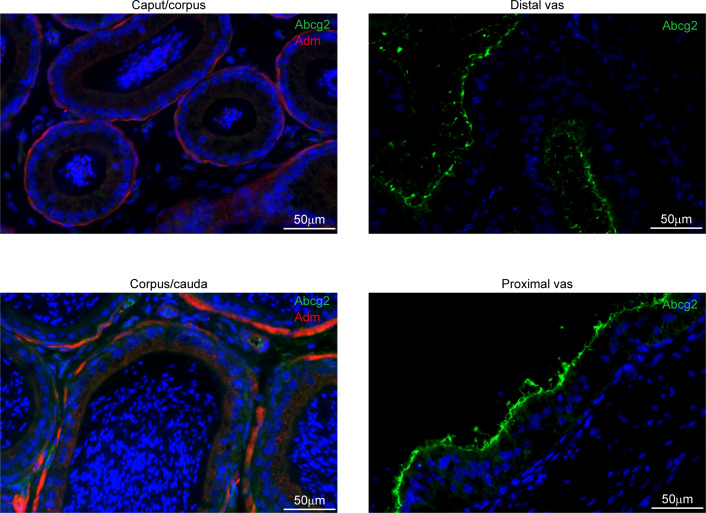
Apical localization of Abcg2 in the vas deferens.Left panels: immunostaining for Adm (a basal cell marker, in red) and Abcg2 (specific to vas deferens principal cells, in green), and counterstained with DAPI, in the epididymis. Images from the epididymis show Adm-positive basal cells, with no Abcg2-positive cells, as expected. Along with secondary only controls (not shown), the absence of Abcg2 staining in the epididymis provides additional negative controls for the other immunostaining studies in this manuscript. Right panels: vas deferens images show Abcg2 and DAPI staining, confirming widespread principal cell expression and predicted apical staining of Abcg2.